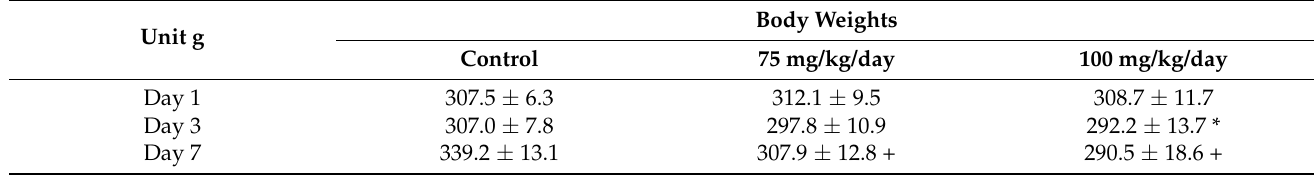
Table 1. Body weights results obtained on 1-week consecutive ifosfamide-administered rats. Unit